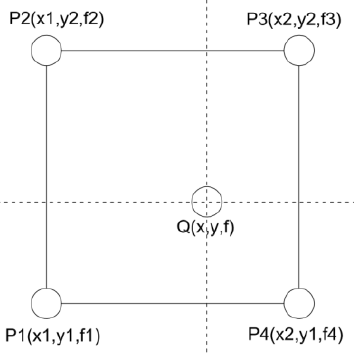
Figure 4. The parameter settings of preprocessing. ( a ) Interference suppression. ( b ) ISDFT (Inverse Fourier Transform). ( c ) BGR (high pass). ( d ) Autoscale.